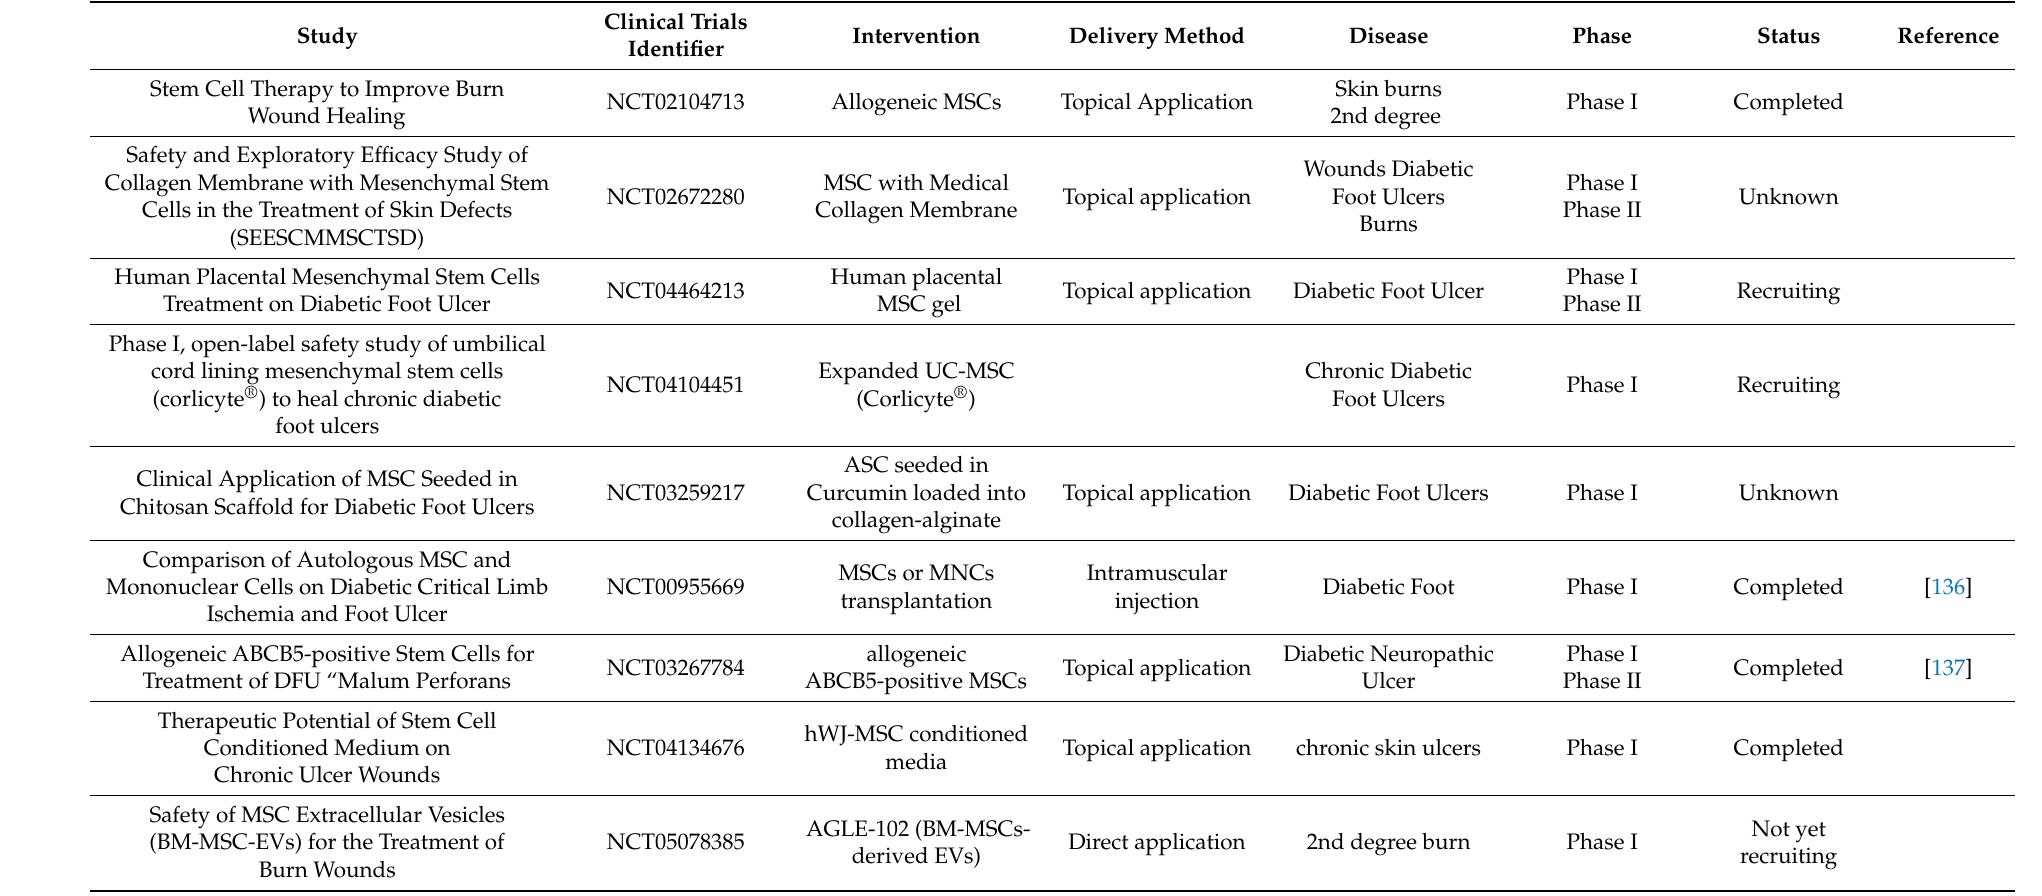
Table 3. Clinical Trials that utilized MSCs in wound